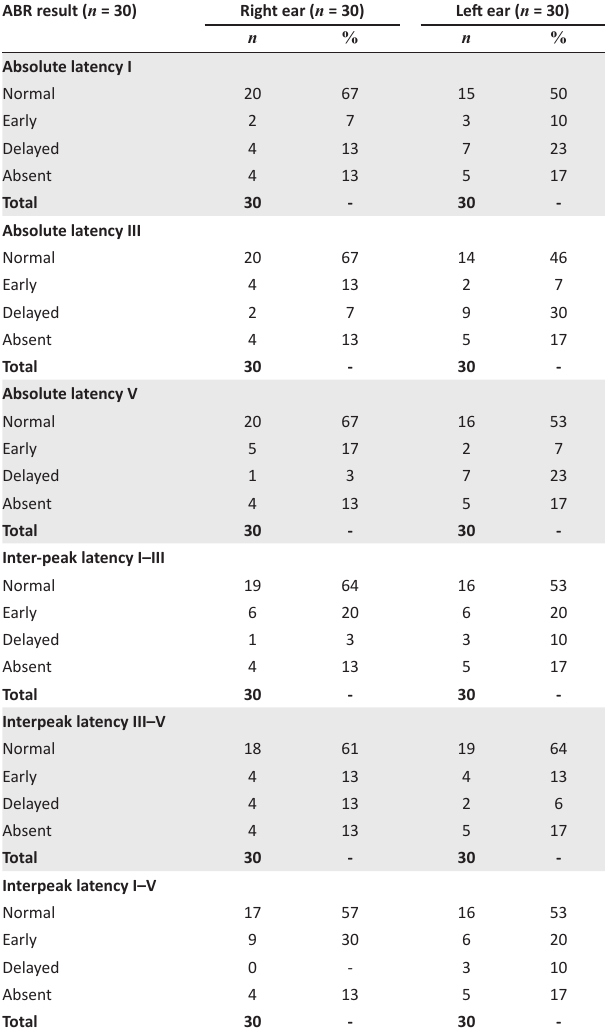
TABLE 5: Neurological auditory brainstem response ABR results. ABR result ( n = 30)